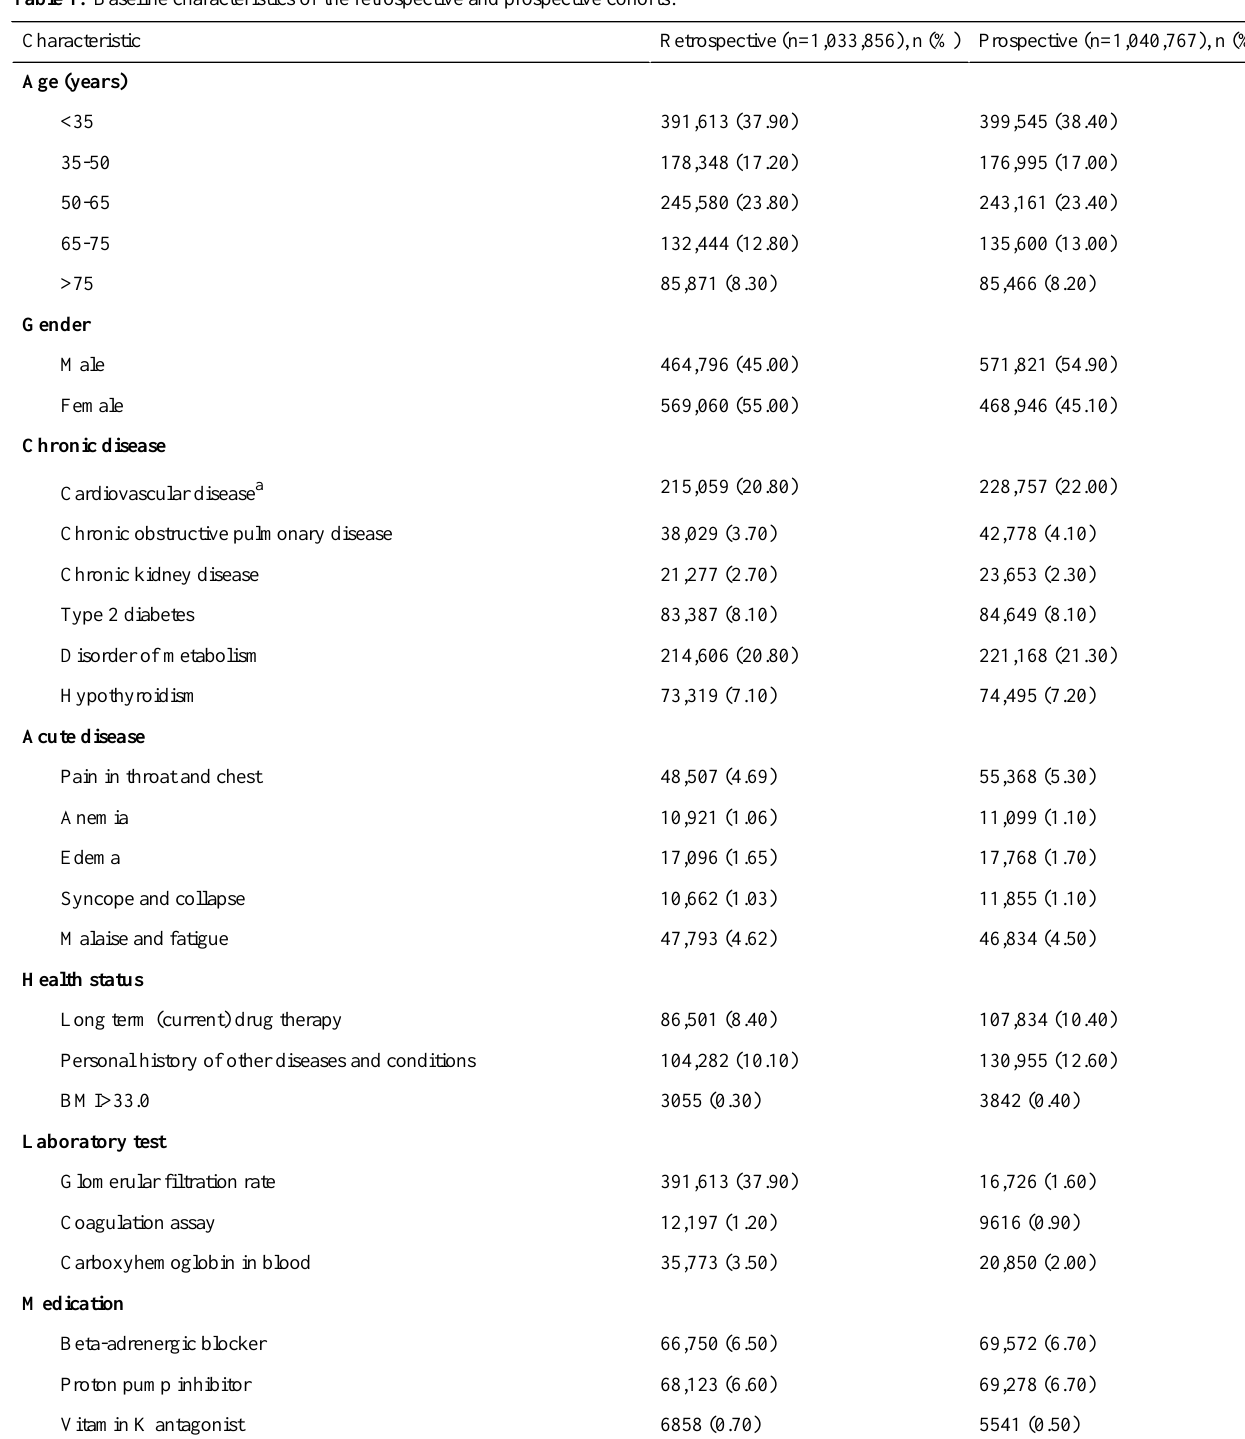
Table 1. Baseline characteristics of the retrospective and prospective